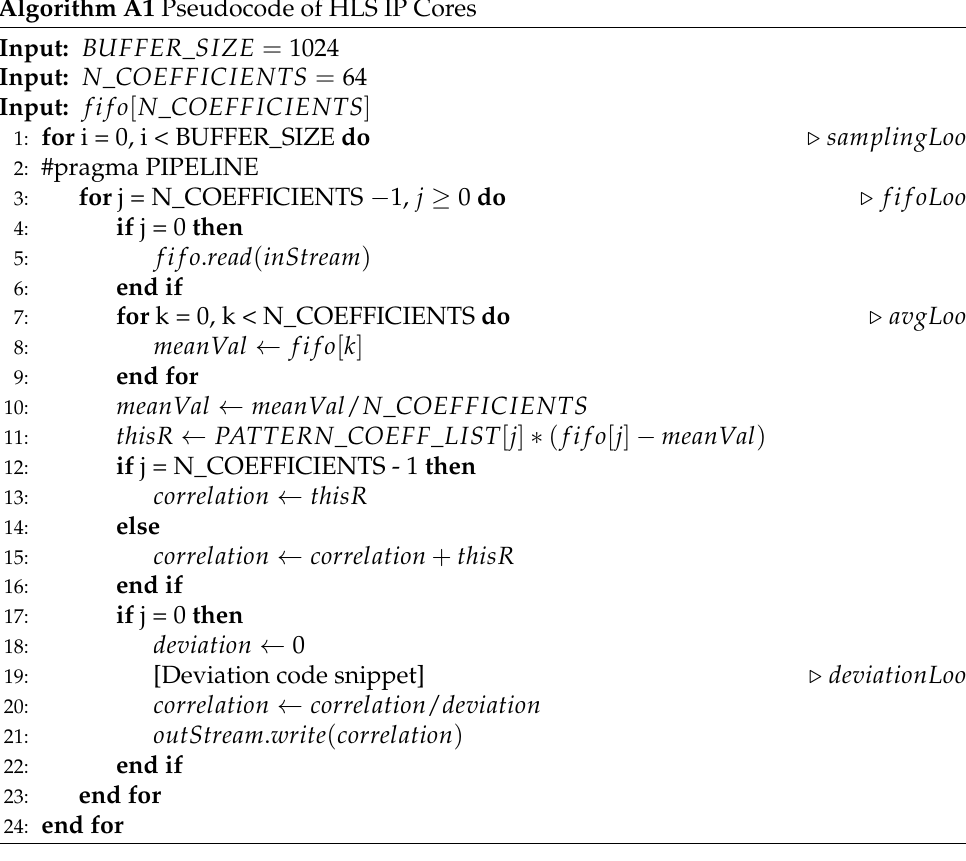
Algorithm A1 Pseudocode of HLS IP Cores